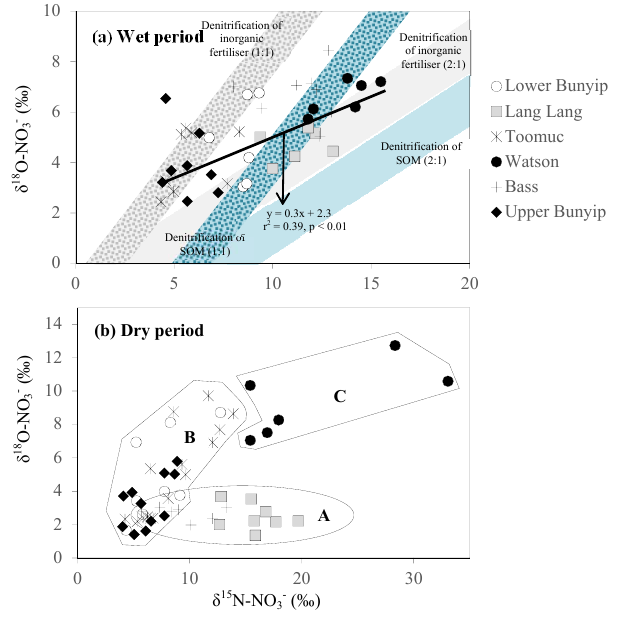
vs. δ 18 O–NO − for Bunyip and 3 3 3 is the δ 15 N- 3